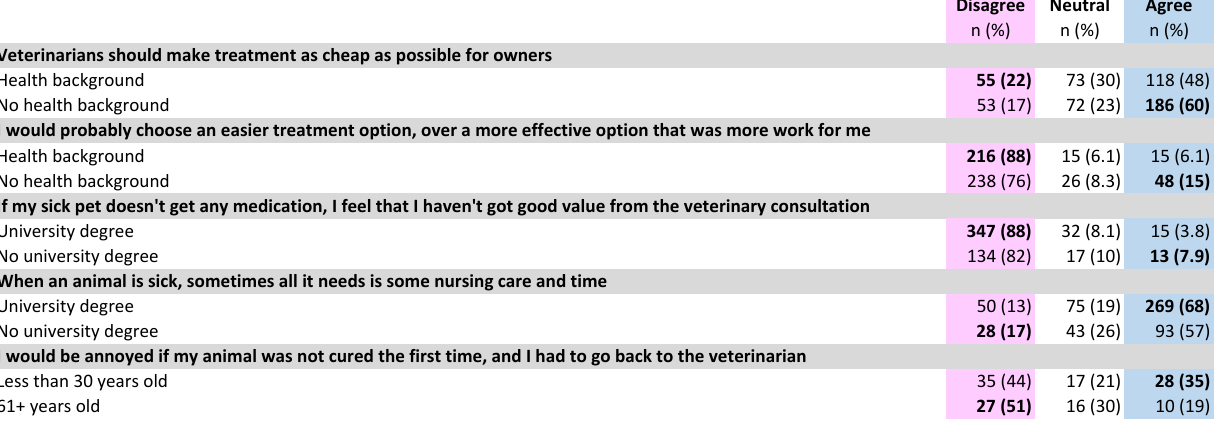
Figure 7. Differences by respondent demographic category in pet owner expectations of a veterinary consultation, treatment preferences and trust. Bold text indicates a significantly higher subgroup result ( p <